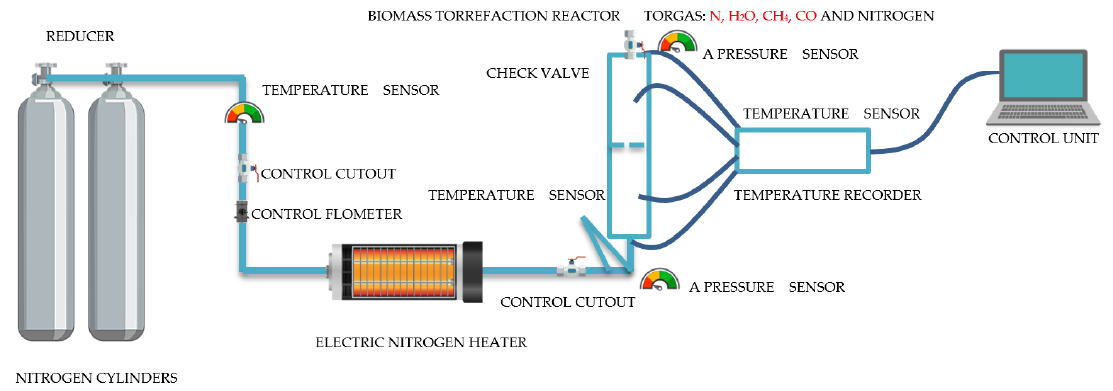
Figure 13. Scheme: installation with a batch reactor for the Jerusalem artichoke torrefaction process using nitrogen.